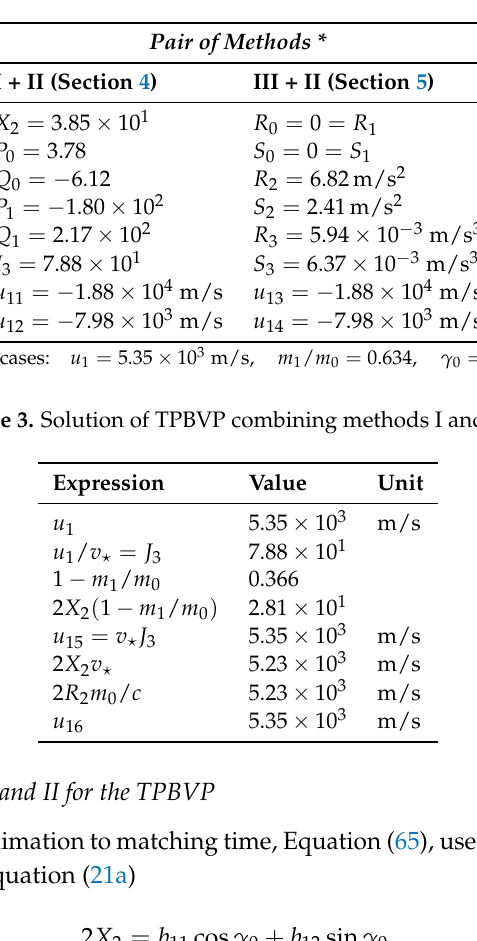
Table 2. Application of distinct pairs of methods to TPBVP.